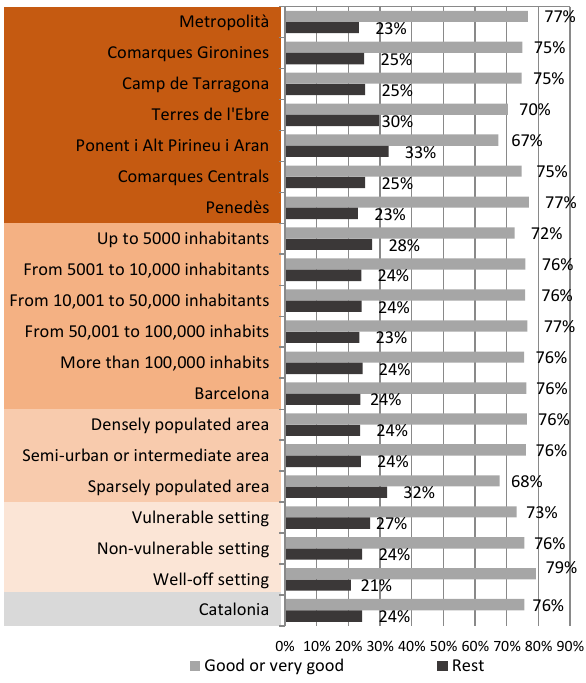
Figure 5. Self-perceived health. Population aged 16 years and over. Catalonia. Source: In-house construction based on the ECVHP, 2011.